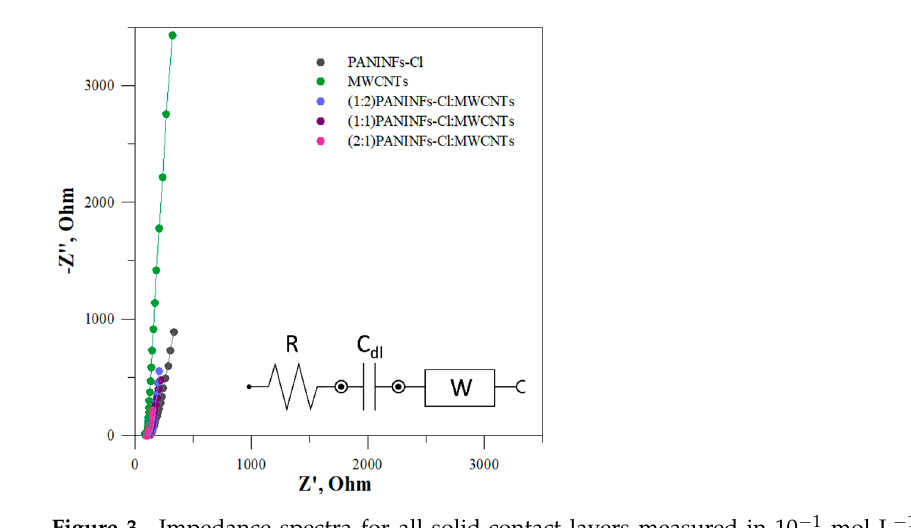
Figure 3. Impedance spectra for all solid-contact layers measured in 10 − 1 mol L − 1 NaCl with an equivalent electrical circuit (solid lines represent data fits; the error of the fits χ 2 is given in Table 2). Table 2. Electrical parameters for the tested electrodes determined by EIS.